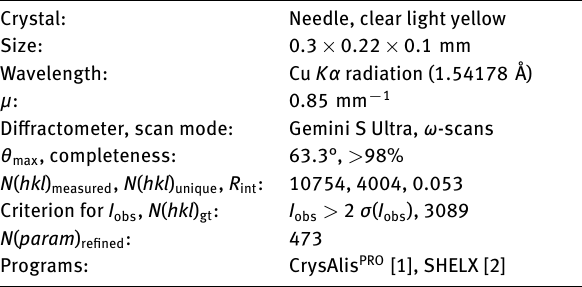
Table 1: Data collection and